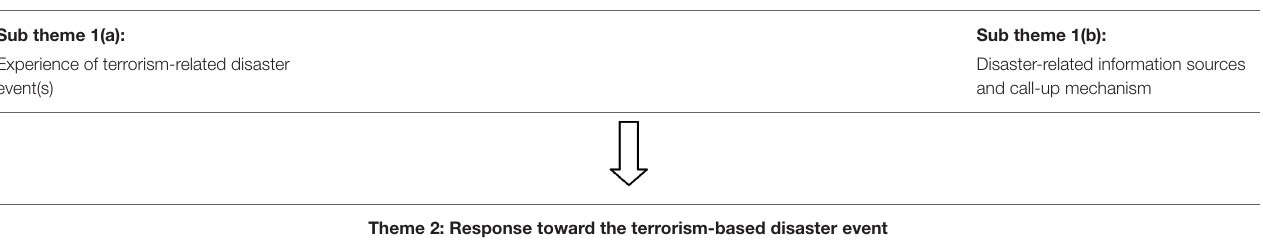
TABLE 2 | Schematic presentation of themes and sub themes identified during data analysis. Theme 1: Terrorism-related disaster event (experience, information source and call-up